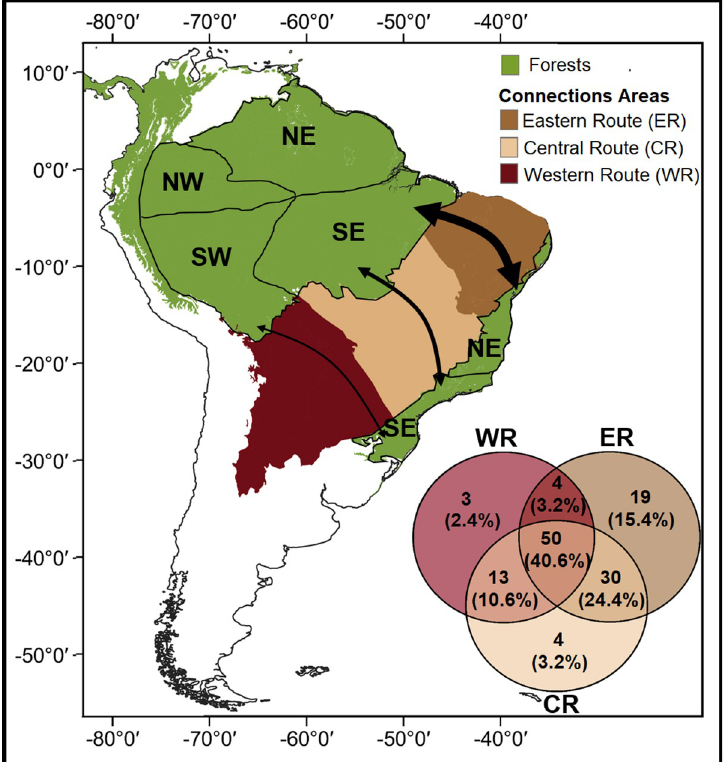
Fig 1. Distribution of tropical moist forests in South America (in green) and potential past dispersal routes (in browns) between Amazonia and the Atlantic Forest. Internal arrows represent connective routes between these forests through the Eastern route (dark brown), the Central route (light brown) and the Western route (reddish- brown). The width of the arrows represents the potential frequency by which the routes have been used in the past and is based on mammal species distributions. The coloured regions in the map were delimited using the Ecoregions shapefile from Dinerstein et al. (2017) licensed under CC-BY 4.0 (https://creativecommons.org/licenses/by/4.0/). The map was created in QGIS v.3.6.2 (https://www.qgis.org/) licensed under CC-BY-SA 3.0 (https://creativecommons.org/ licenses/by-sa/3.0/https://creativecommons.org/licenses/by/4.0/). The Venn diagram shows the number of mammalian species that may have used the past connective routes between Amazonia and the Atlantic Forest, based on the IUCN geographical distribution